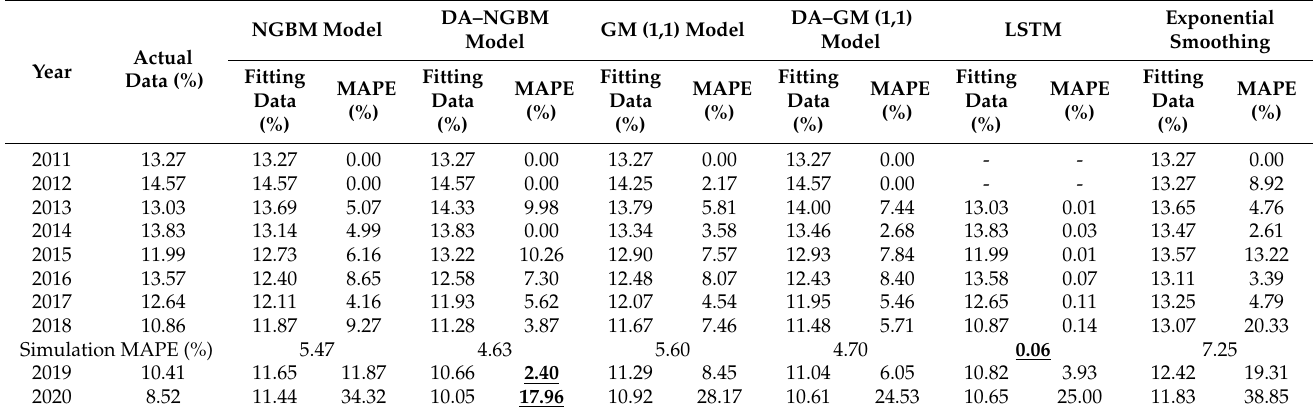
Table 3. Comparison of fitting and predicted birth rate in China from 2011 to 2020.